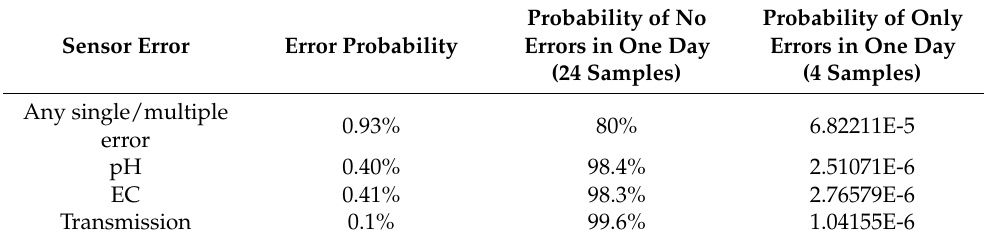
Table 6. SCU error